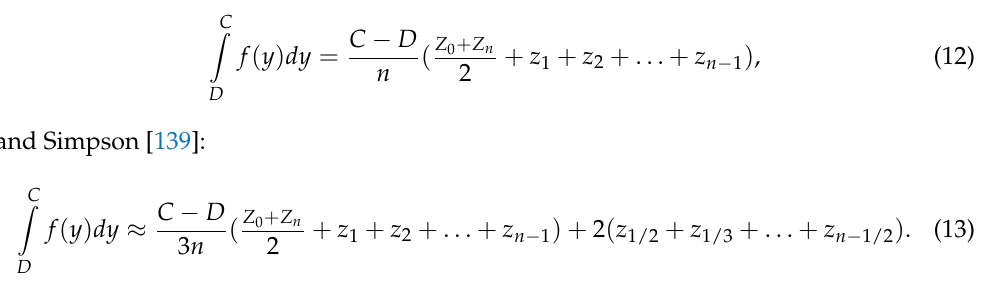
mined from the area of the curvilinear trapezoid: